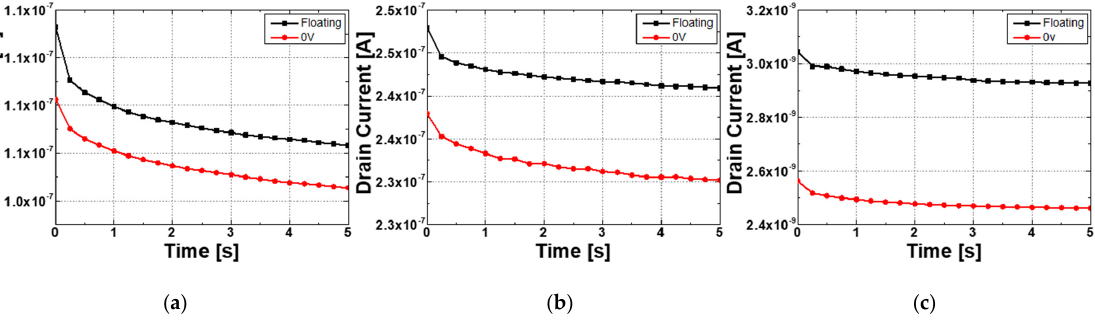
type; ( c ) NRs stacked type.